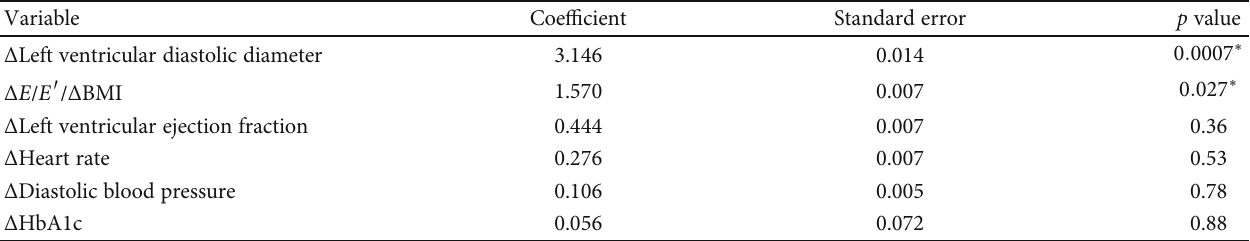
Table 3: Multivariate linear regression to relative changes in B-type natriuretic